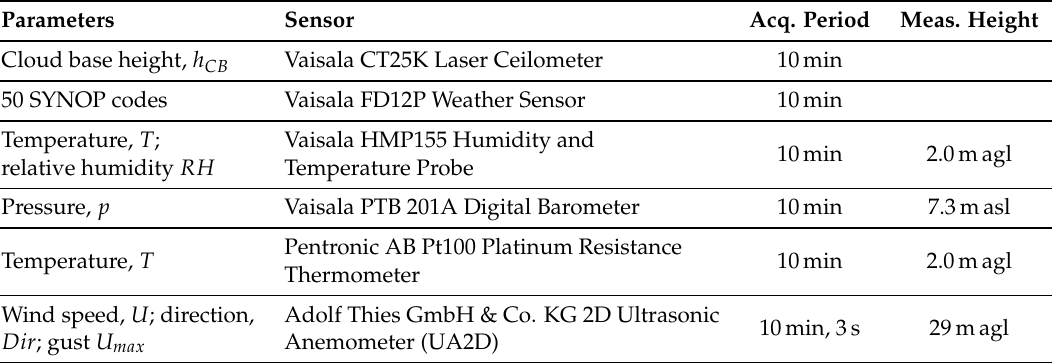
Table 1. Specifications of the operational automatic weather station (WMO station ID 02873) at Hailuoto.